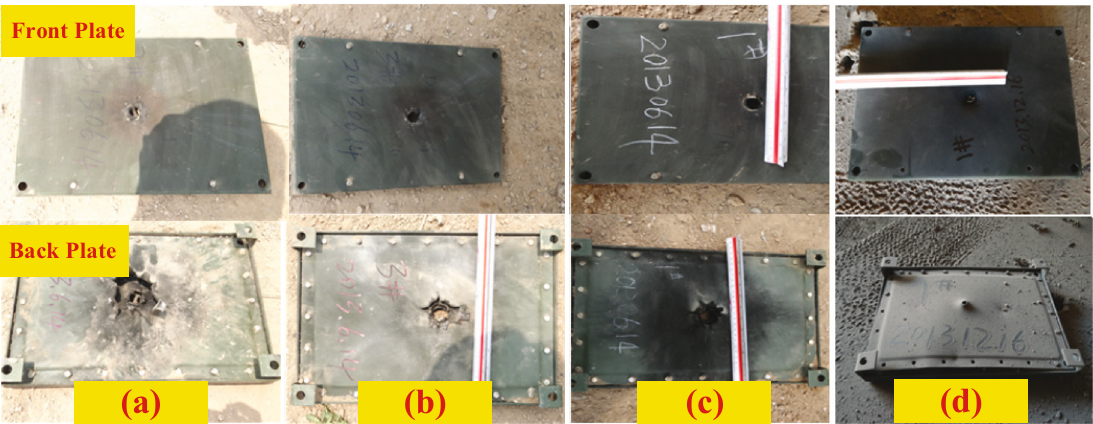
Figure 9: Experimental results of PTFE jets impacting ERA under di ff erent stando ff conditions: ( a ) stando ff = 2CD, ( b ) stando ff = 3CD, ( c ) stando ff = 4CD, and ( d ) stando ff = 5CD.